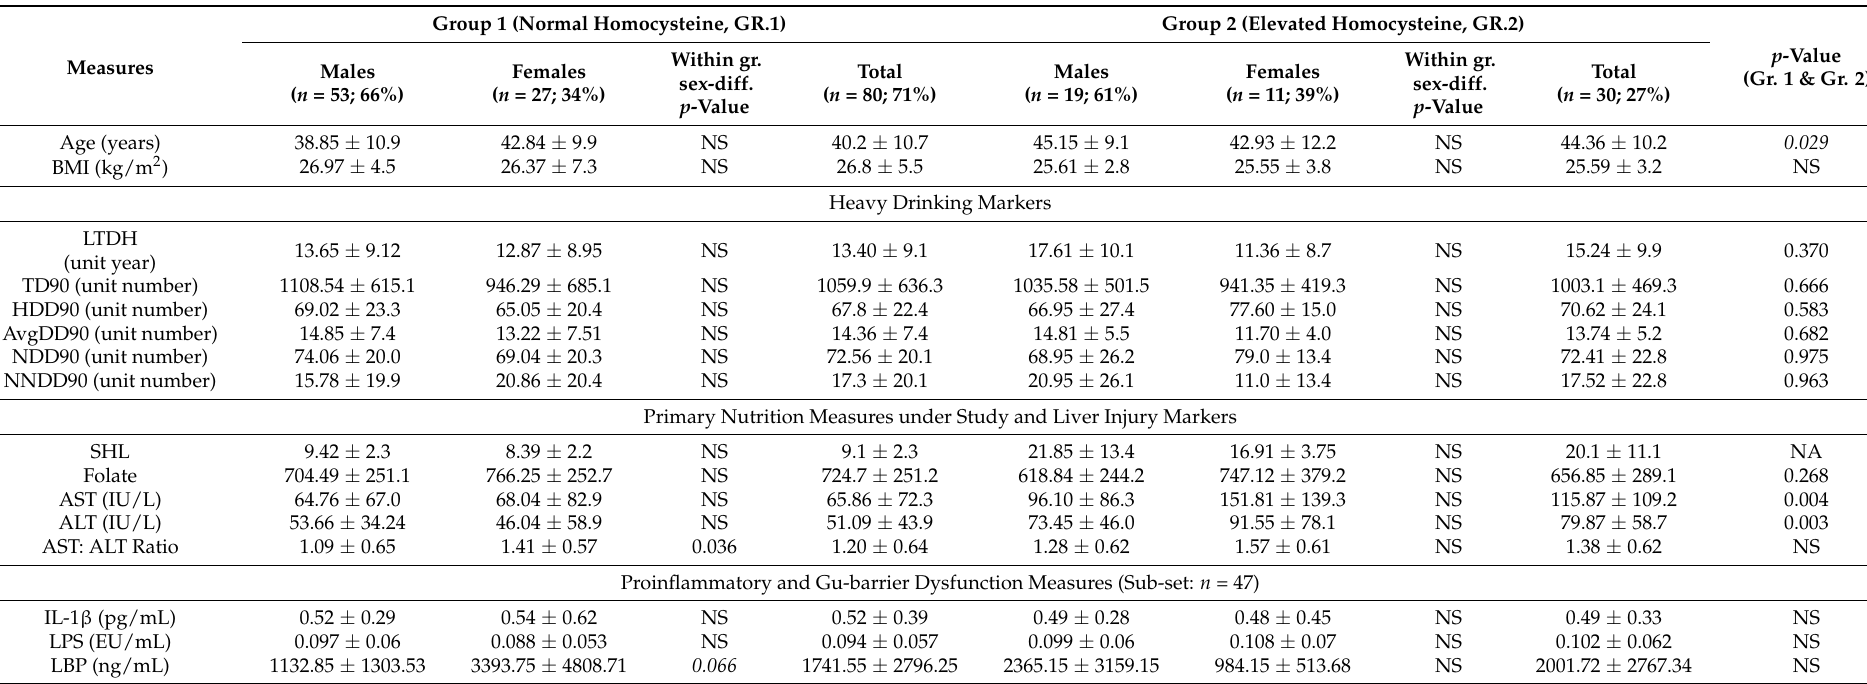
GR.1: patients with normal serum homocysteine; GR.2: patients with high serum homocysteine level; LTDH: Lifetime Drinking History; TLFB: Timeline Followback (Total drinks in the past 90 days (TD90), Number of drinking days in the past 90 days (NDD90), Drinks per drinking day in the past 90 Days (DPD90), Average drinks per drinking day in the past 90 days (AvgDD90), and Heavy drinking days in the past 90 Days (HDD90)); SHL: serum homocysteine levels; AST: aspartate aminotransferase; ALT: alanine aminotransferase; IL1 β : Interleukin-1 beta; LBP: lipopolysaccharide binding protein; LPS: lipopolysaccharide. Italicized p -value: not applicable for co-variable analysis since same age-group. NA: not applicable, NS: not